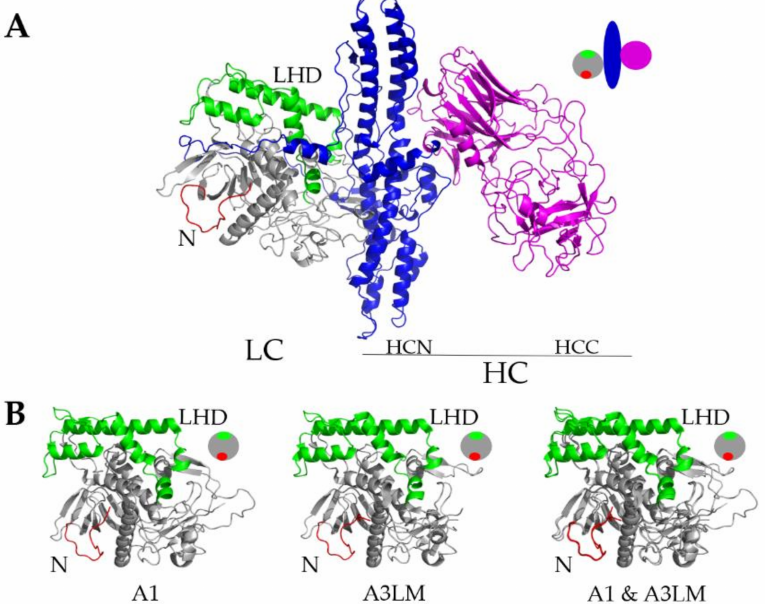
Figure 1. ( A ) Structure of botulinum neurotoxin A (BoNT/A) (PDB: 3BTA). ( B ) Structural alignments of A1 and A3LM. The light chain (LC) is shown in gray, the N in red, and LHD in green A1 (PDB: 1XTG) and middle A3LM (PDB: 7DVL) [31] and right A1 and A3LM merged with N (residues 1–17, red) and LHD (268–357, green) highlighted. Merge of A1 and A3LM was prepared with PyMol software. Circle schematic of LC:N (red), LHD (green), regions outside (gray), HC:HCN (blue), and HCC